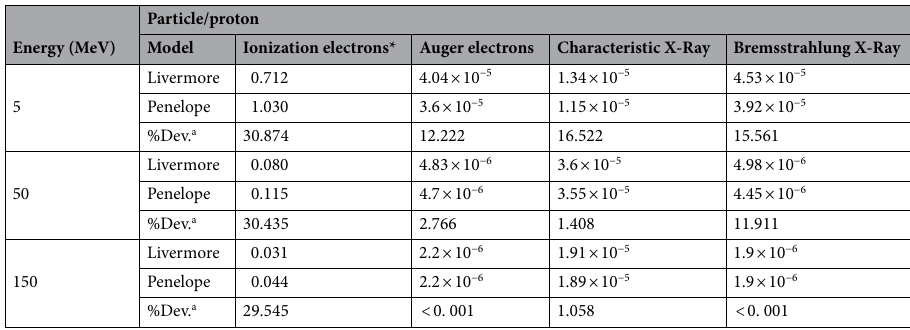
Table 1. The total number of secondary particles (statistical uncertainty < 1%) around GNP based on Livermore and Penelope models obtained for 5, 50, and 150-MeV proton beams. a Deviation between Livermore and Penelope. *Electrons deriving from the ionization process.